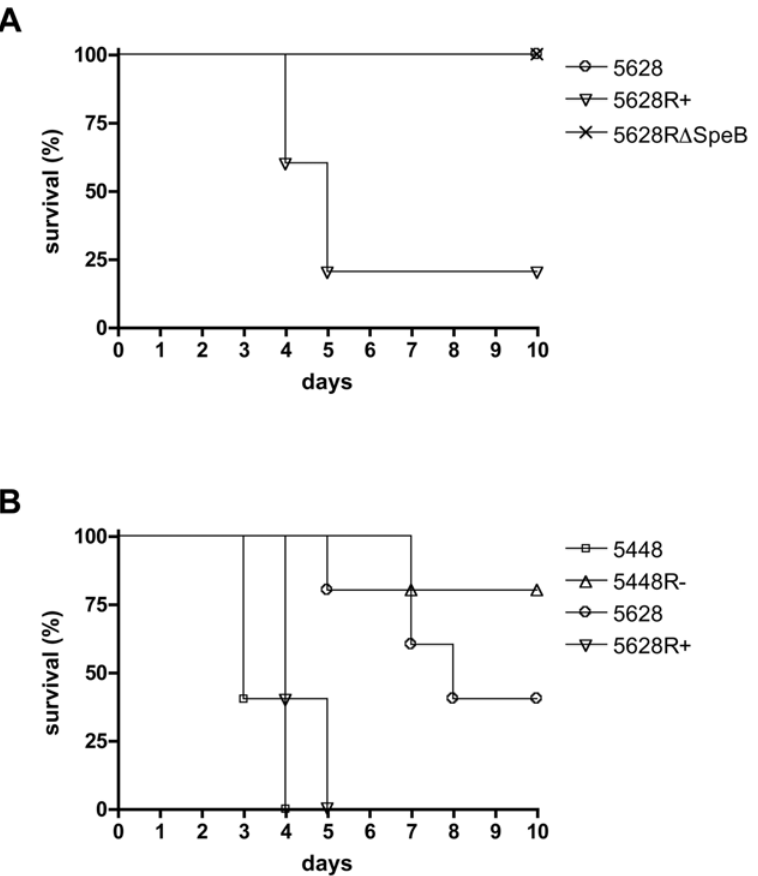
Figure 4. RopB and SpeB-negative bacteria show reduced virulence in systemic infection models. (A) Intraperitoneal infection of C57BL6/J mice with 5 6 10 7 cfu of GAS strains with 5% mucin. (B) Intravenous challenge of C57BL6/J mice with 2 6 10 8 cfu of GAS